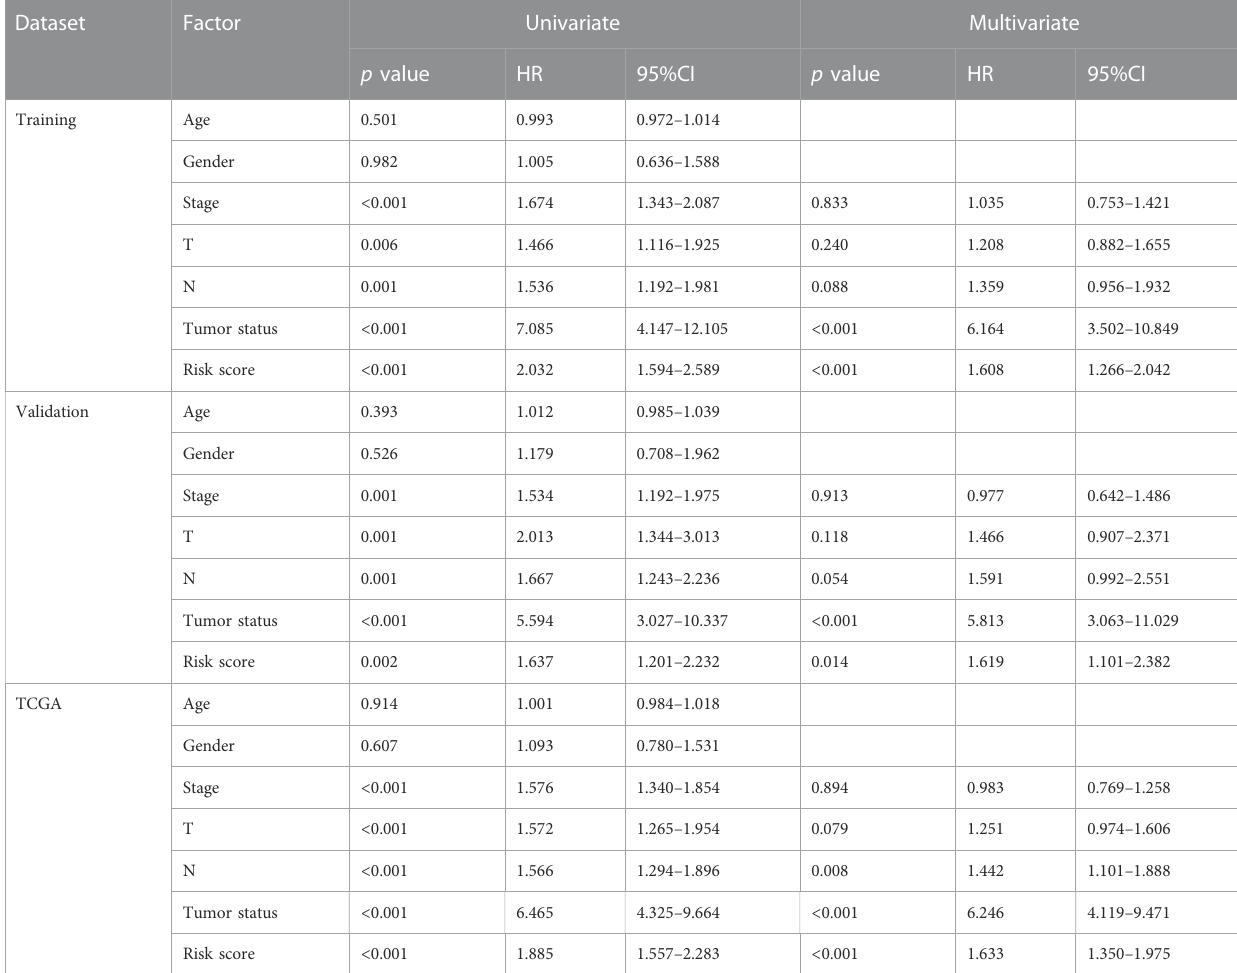
TABLE 2 Independent prognostic analysis for clinicopathological variables and risk scores by Cox regression. Dataset